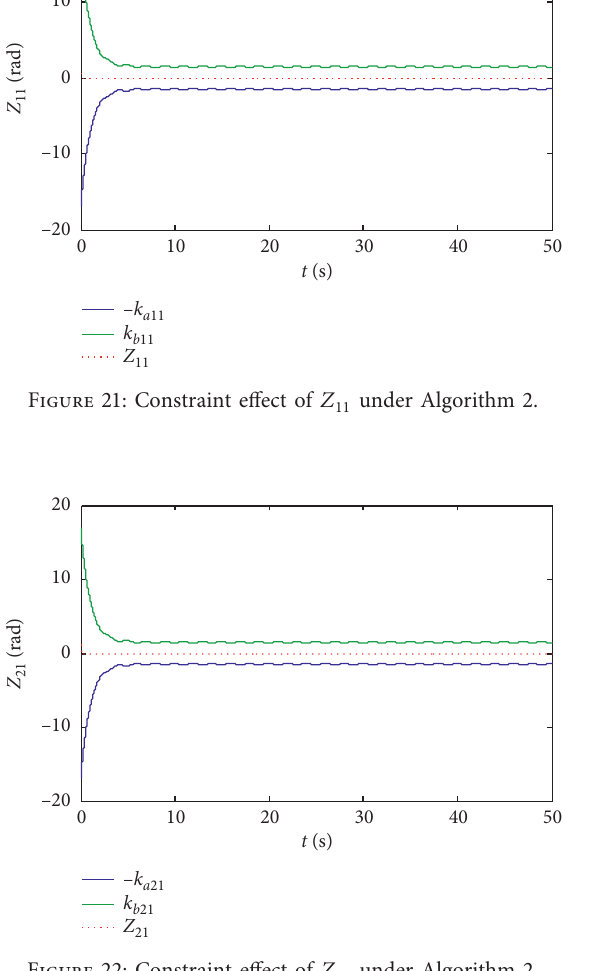
under Algorithm 2. 21